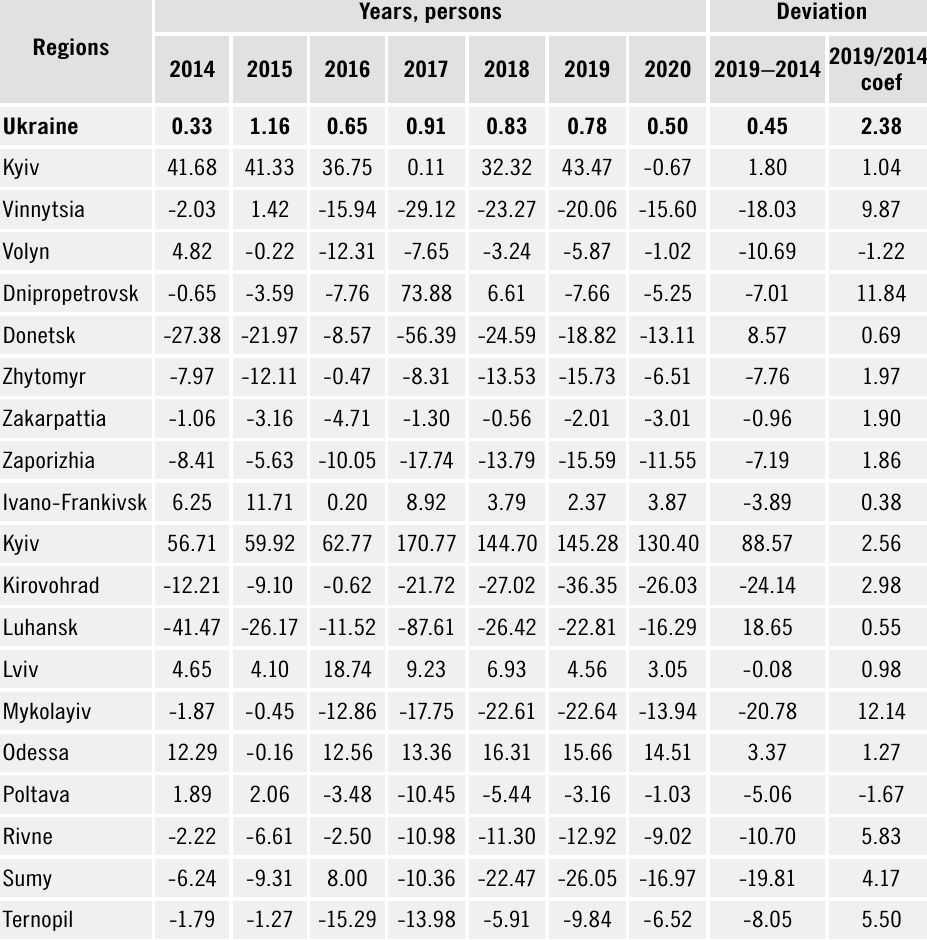
Table 3. Total net migration coefficients in Ukraine; regional breakdown for 2014–2020